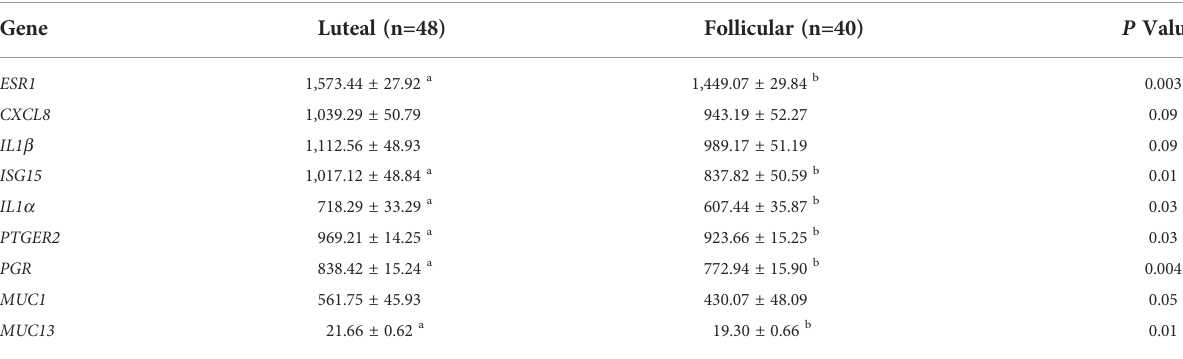
TABLE 2 Expression of genes affected by phase of the estrous cycle.